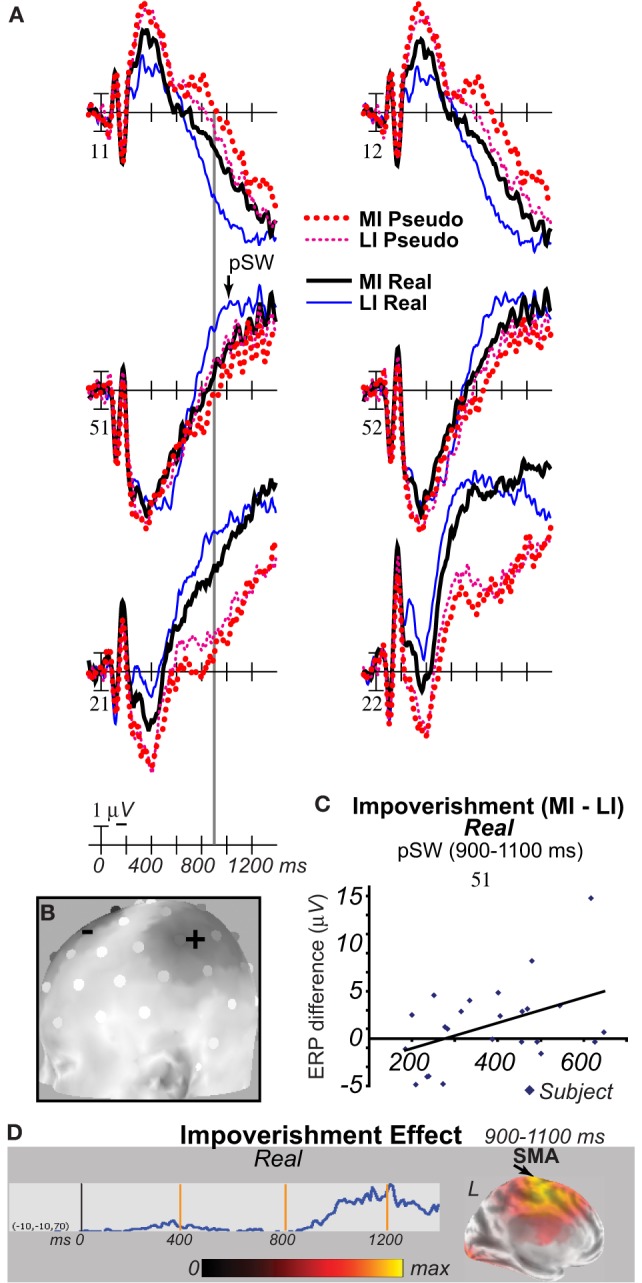
Late ERP slow waves (SW) show main effects of impoverishment and object type after 900 ms until response, localize to supplementary motor area (SMA), and correlate with RT effects. (A) Grand average ERPs show effects of impoverishment (more [MI], less [LI] impoverished) and object type. ERPs at lateral sites of the SW (11–12), a posterior slow wave (pSW; 51–52), and type effects (21–22) are plotted negative up. Image type and impoverishment modulated distinct ERPs even after 900 and until the latest responses around 1400 ms for MI pseudo objects. An impoverished-real-object effect on a late pSW started after 900 ms (gray line). (B) Voltmap generated using sLORETA (default left mastoid reference) shows the distribution of voltage differences over the left hemisphere from 1100 to 1400 ms when only the SMA effect occurs; the distribution is similar from 900 to 1100 ms. Electrodes symbolized by half spheres. The + sites are where the pSW effect is strongest (MI - LI), whereas—sites are the location of the SW over frontal scalp (LI - MI). (C) Across subjects, the RT difference correlated significantly with the late pSW effect. Each diamond plots the RT and ERP values for each subject. RT difference on x-axis. ERP amplitude difference on y-axis. The computed linear regression line (solid) is shown. Impoverishment difference for real objects (MI minus LI) from 900 to 1100 ms at site 51 correlated such that, on MI relative to LI trials, as the pSW became more positive, RTs got slower. (D) Maps from sLORETA for 900 to 1100 ms on the left (L) medial surface show the late SMA (BA 6, −15 −10 55; 5 −5 65) impoverishment effect for real objects, extending into anterior cingulate gyrus (BA 24, −15 −10 50), and estimated intracranial ERPs show the SMA effect started after 900 ms. Specifically, from 900 to 1100 ms, sources of impoverishment effects for real objects continued in striate/extrastriate and anterior temporal cortex, and, for the first time, were located in left more than right SMA and anterior cingulate, and this effect appeared to correspond to the pSW. From 1100 to 1400 ms, the SMA effect continued, but extended dorsally into superior frontal gyrus (BA 6, −10 [−10 or −15] 70), and posterior effects were minimal or none. At these times, the impoverishment effect for pseudo objects localized to striate/extrastriate areas (BA 17/18) with weaker sources in temporal pole (BA 38, −40 20 −35) and inferior frontal gyrus (BA 47, −50 45 −10). Note, the sLORETA map shows estimated sources of the difference wave (MI - LI) in the grand average ERPs superimposed on an inflated, canonical MNI152 brain (Colin); dark areas represent sulci; light areas represent gyri. The depicted brain shows standardized cortical current density distributions, and source activity reflects the location of differential source activity between conditions but not the direction of effects. Scale shows yellow represents maximal current density value differences. Estimated intracranial ERPs from −100 to 1400 ms were extracted from the voxel showing maximum impoverished-real-object effects at MNI coordinates from 900 to 1400 ms in SMA (−10 −10 70). Solid tics mark the 0 ms stimulus onset and 400 ms intervals post-stimulus.